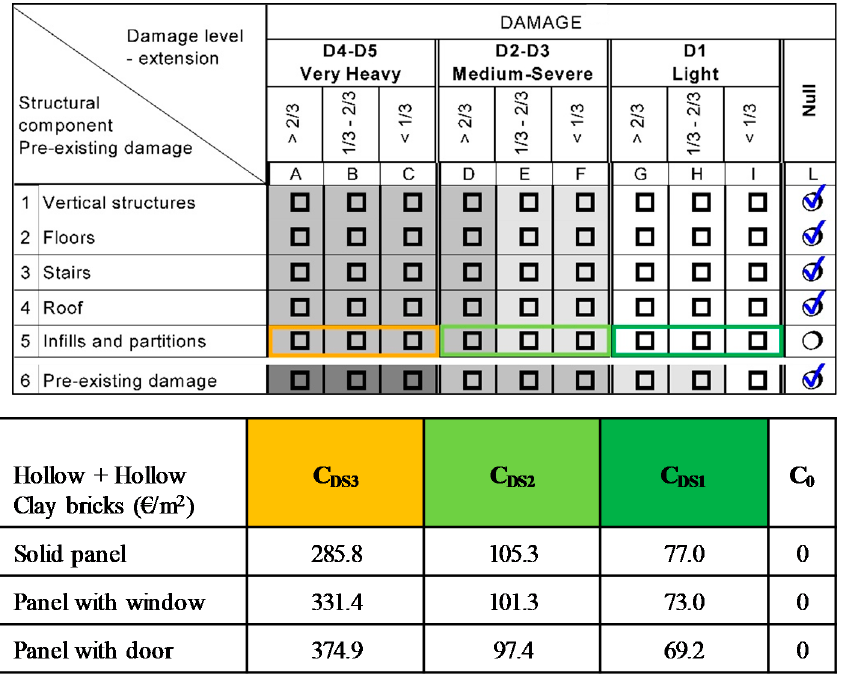
TOT ) for double leaf hollow clay TOT C ) for double leaf hollow clay bricks. Figure 11. Repair costs (C DSi DSi